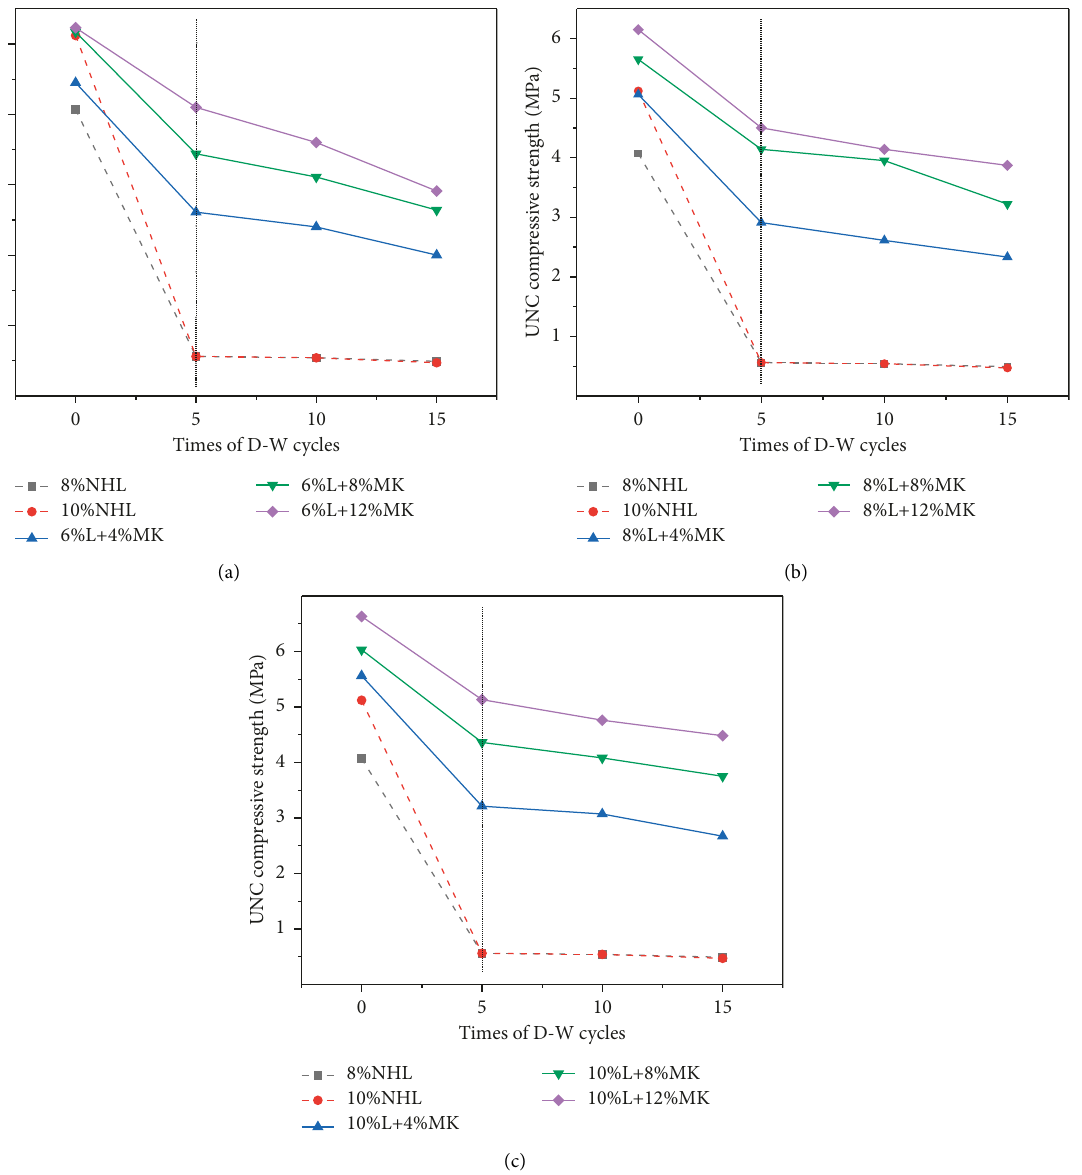
Figure 6: Relationship between the compressive strength of L-MK- and NHL-modified soils and the number of dry-wet cycles. (a) 6% L-MK and NHL. (b) 8% L-MK and NHL. (c) 10% L-MK and